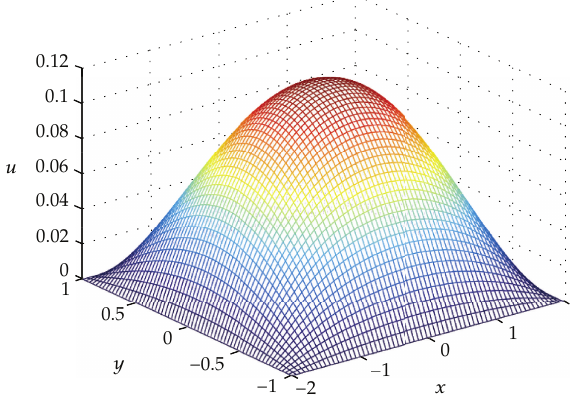
Figure 2: Solution in the case of a (cid:10) 0 . 5 and b (cid:10)